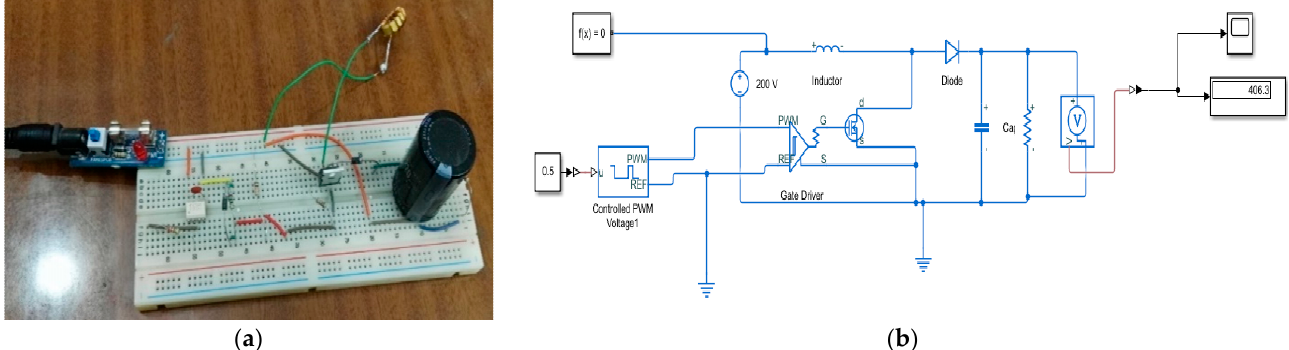
Figure 11. ( a ) Boost converter circuit; ( b ) MATLAB-Simscape model for the boost converter.